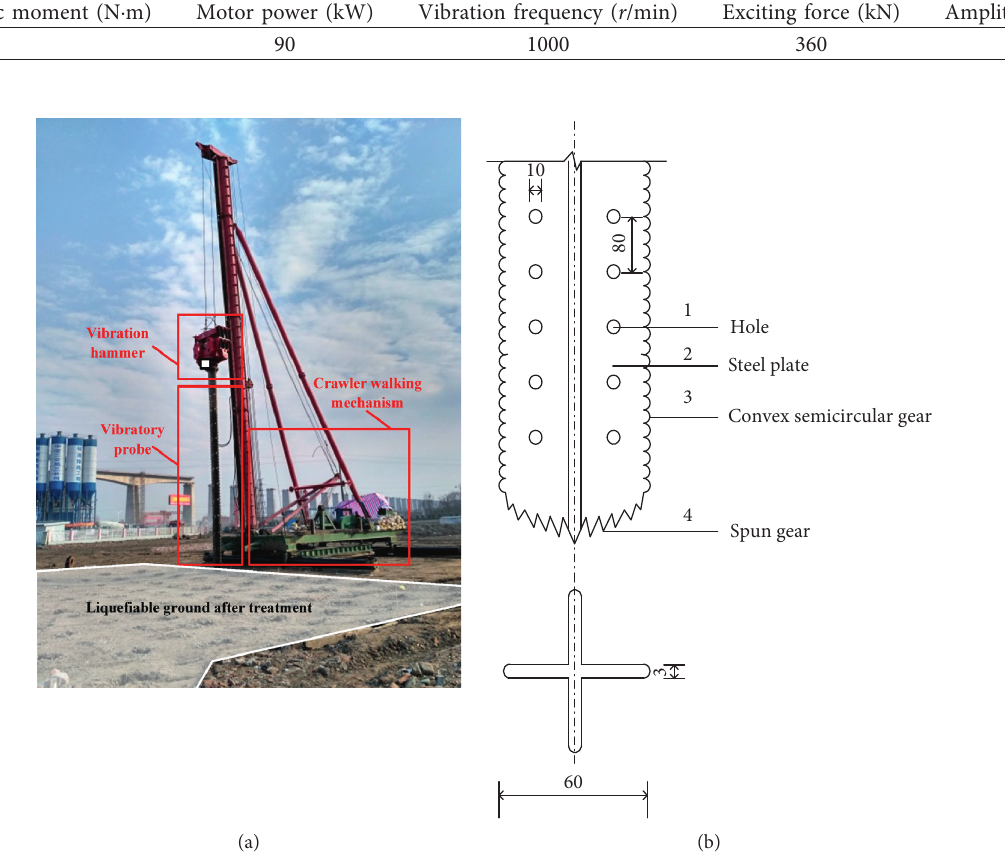
Figure 1: CSP resonant vibrating equipment. (a) CSPRCM equipment and (b) cruciform section vibrating probe (cm).